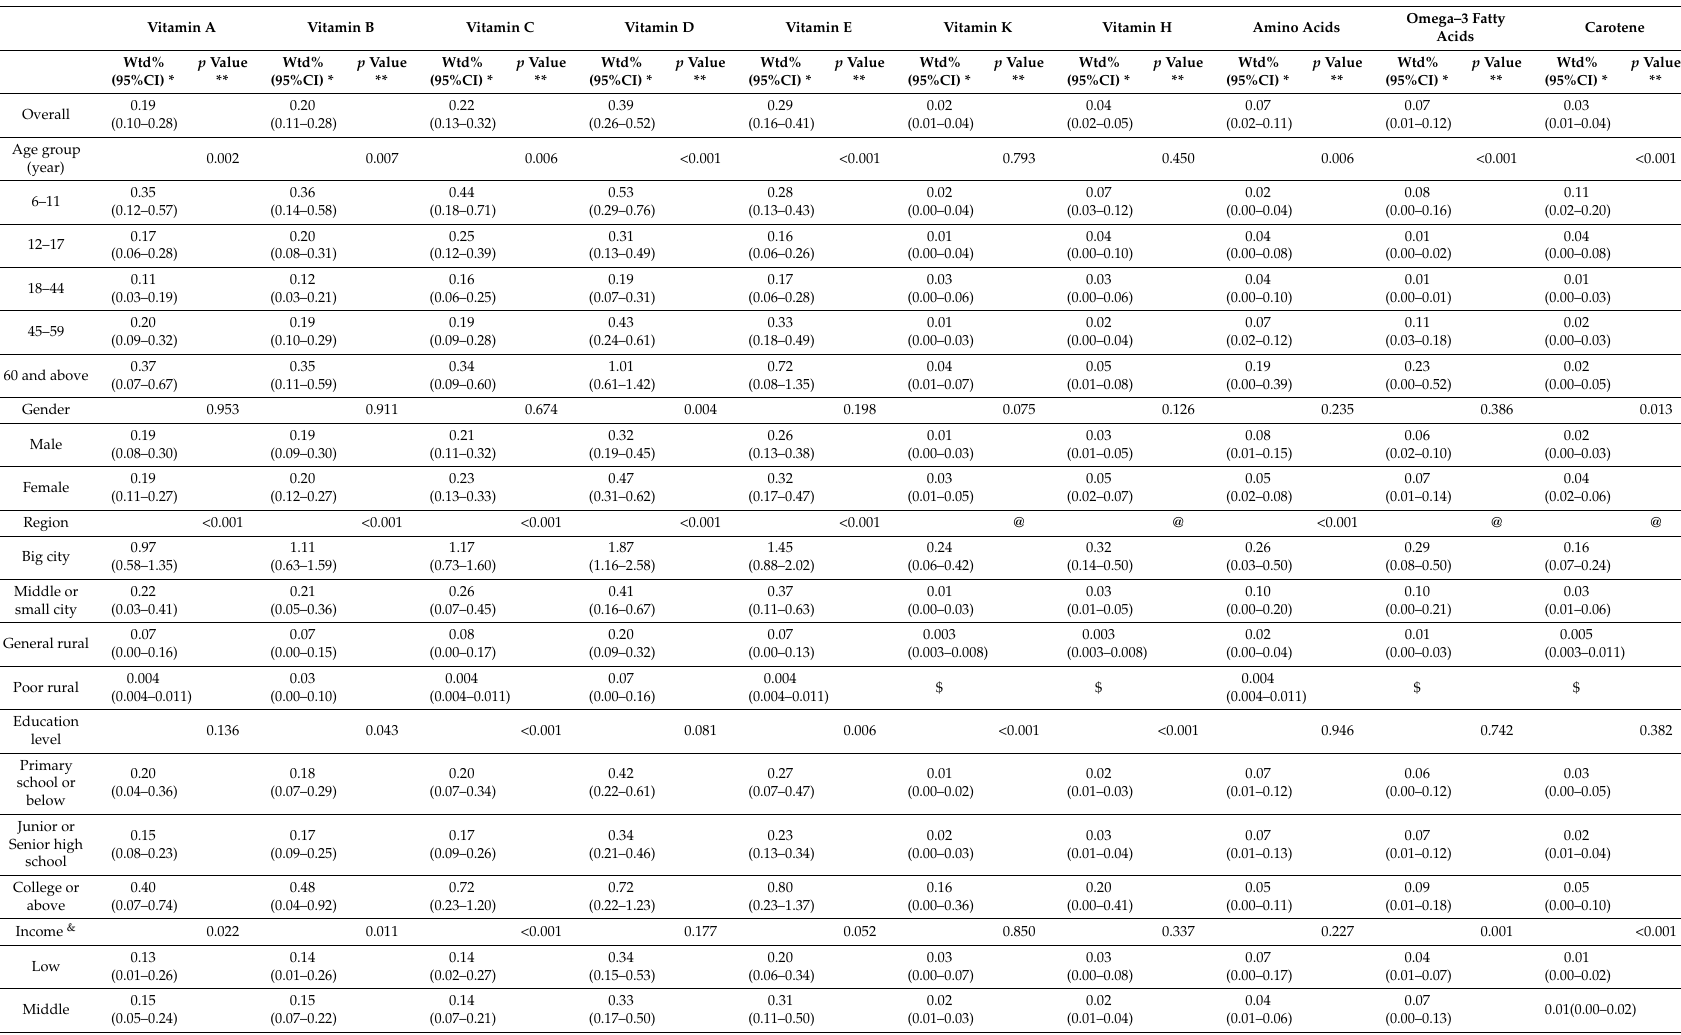
Table 4. The vitamins, Amino acids and Omega-3 fatty acids supplemented among the Chinese population aged 6 years and above in 2010–2012 CNHS. VitaminA VitaminB VitaminC VitaminD VitaminE VitaminK VitaminH AminoAcids Omega–3Fatty Acids